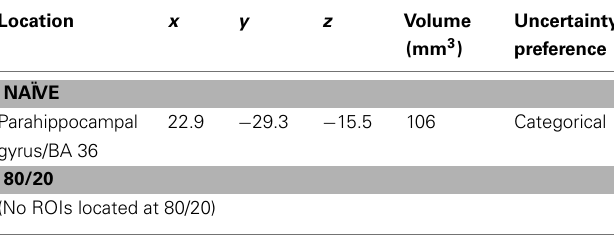
Table 4 | Brain regions selective for uncertainty condition when activity was defined as covariation with degree of uncertainty and the search space was constrained to anterior temporal lobe and perirhinal cortex.